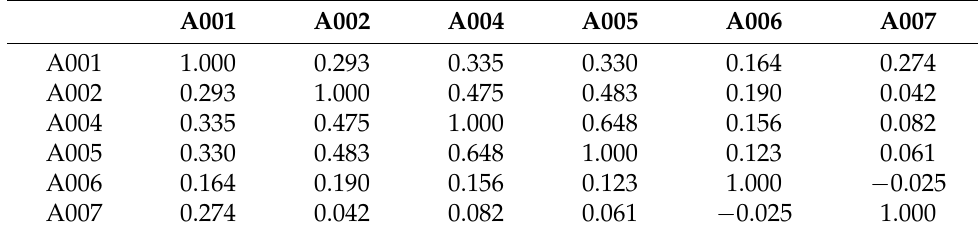
Table 4. Inter-annotator agreement for Round-3 annotation of 1010 images (Appealing/Non-Appealing).